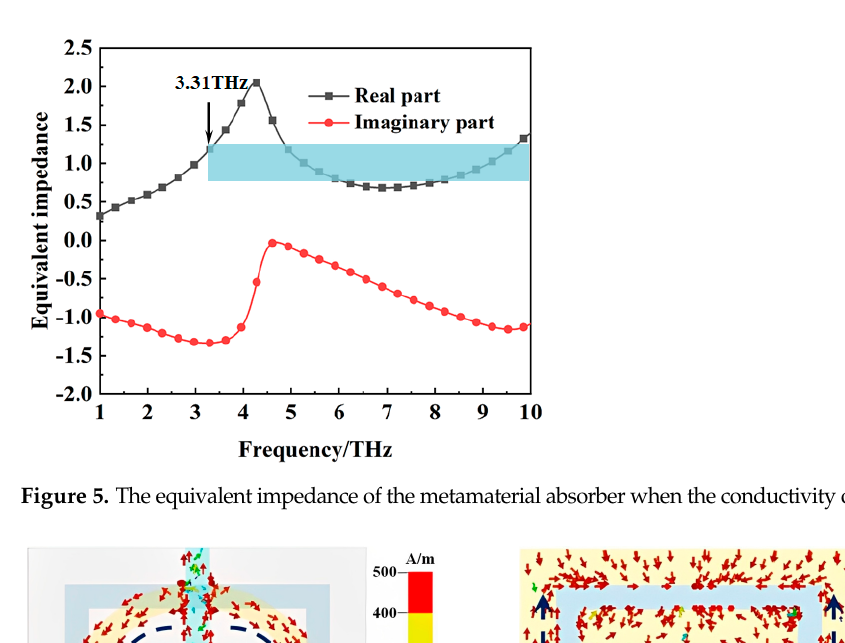
Figure 4. The equivalent impedance of the metamaterial absorber when the conductivity of VO 2 is 2 × 10 5 S/m.